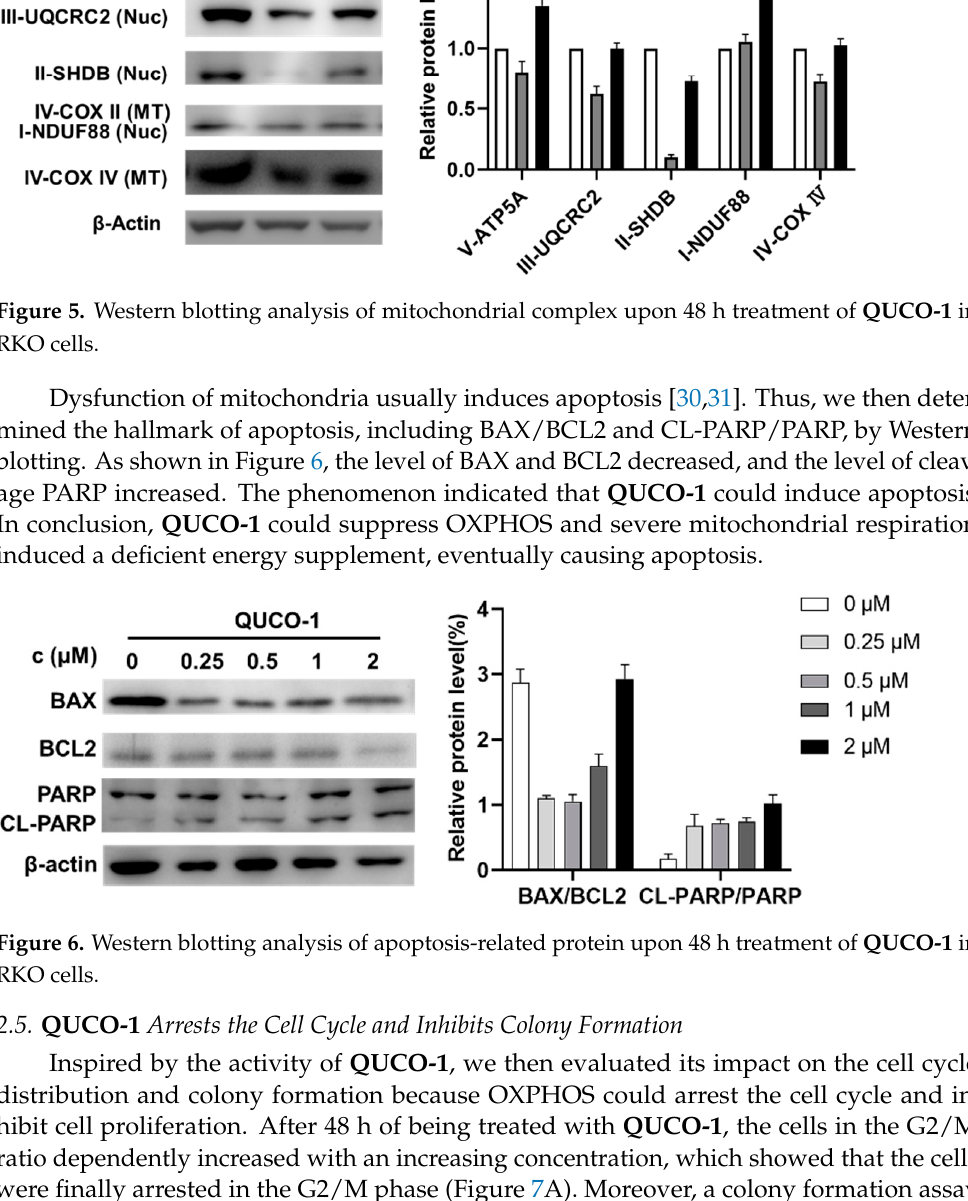
6 of 12 Figure 4. Systematical evaluation of mitochondrial functions with QUCO-1 treatment after 24 h. ( A ) Relative MMP level after compounds were treated; the ratio was MFI/MFI ctrl (%). ( B ) Relative ROS level after compounds were treated; the ratio was MFI/MFI ctrl (%). ( C ) Extracellular flux was deter- mined in RKO cells cultured in 10 mM glucose, 1 mM pyruvate, and 2 mM glutamine. Representa- tive graphs demonstrate the effects of oligomycin, trifluoromethoxy carbonylcyanide phenylhydra- zone (FCCP), and antimycin A/rotenone (A&R) mixture sequentially added for OCR. ( D ) The basal respiration, proton leak, spare respiration capacity, maximal respiration, ATP-linked respiration, and nonmitochondrial oxygen consumption were calculated by Seahorse XF Cell Mito Stress Test Reporter Generator. All the data were derived from three experiments and expressed as the mean ± SEM. Ns: not significant; * p < 0.05; ** p < 0.01; *** p < 0.001, significantly different from the control. 2.4. QUCO-1 Induces OXPHOS Dysfunction and Apoptosis The mtRNA probe QUCO-1 could bind mtRNA, induce mitochondrial dysfunction, and cause OXPHOS inhibition. To verify the mechanism, we then determined the changes in OXPHOS proteins by Western blots in the presence of this probe. As shown in Figure